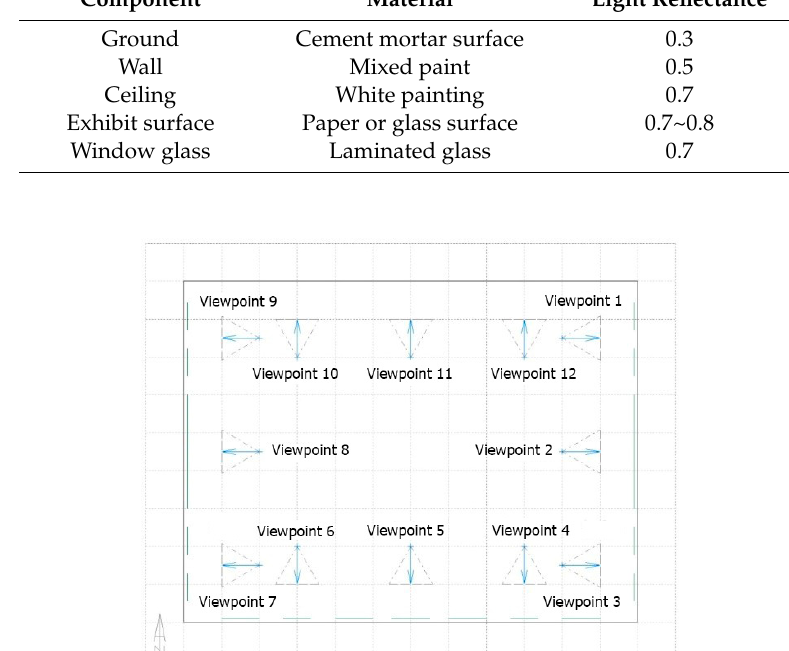
Table 2. Light reflectance of the exhibition hall surfaces.